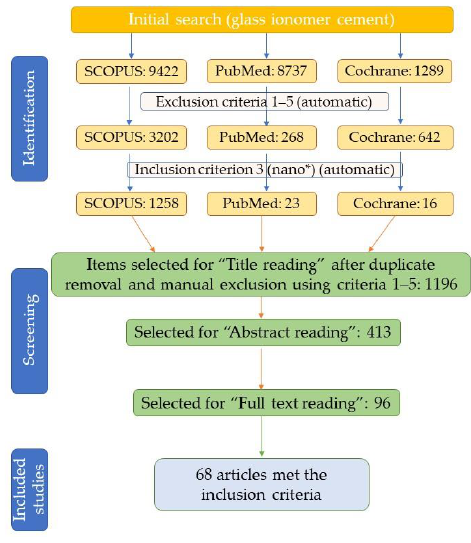
Figure 1. Article selection process flowchart.